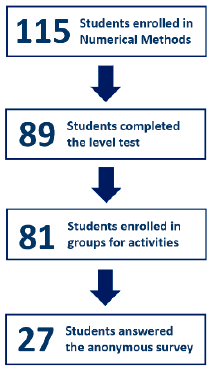
Figure 1. Flowchart sample composition .